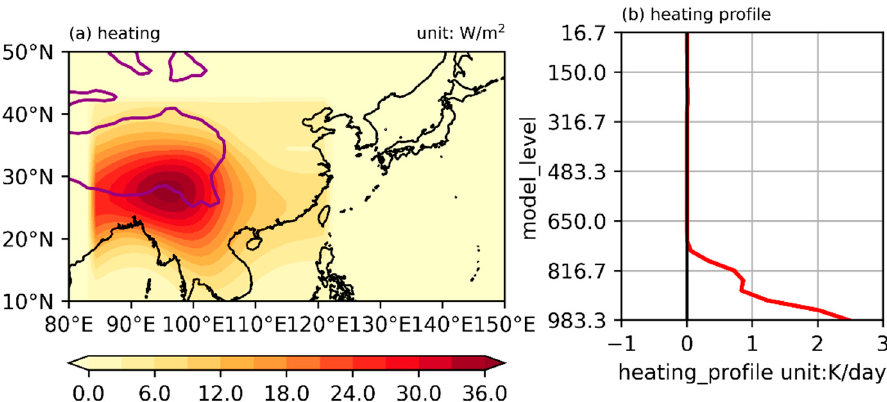
Figure 2. ( a ) The imposed sensible heating (unit: W/m 2 ) and ( b ) its regional mean heating vertical profile (unit: K/day) with the domain (24.5 ◦ N–30.1 ◦ N, 95.6 ◦ E–101.25 ◦ E). The purple line is the profile (unit: K/day) with the domain (24.5°N − 30.1° N, 95.6°E − 101.25° E). The purple line is the 2000 2000 m elevation m elevation contour.